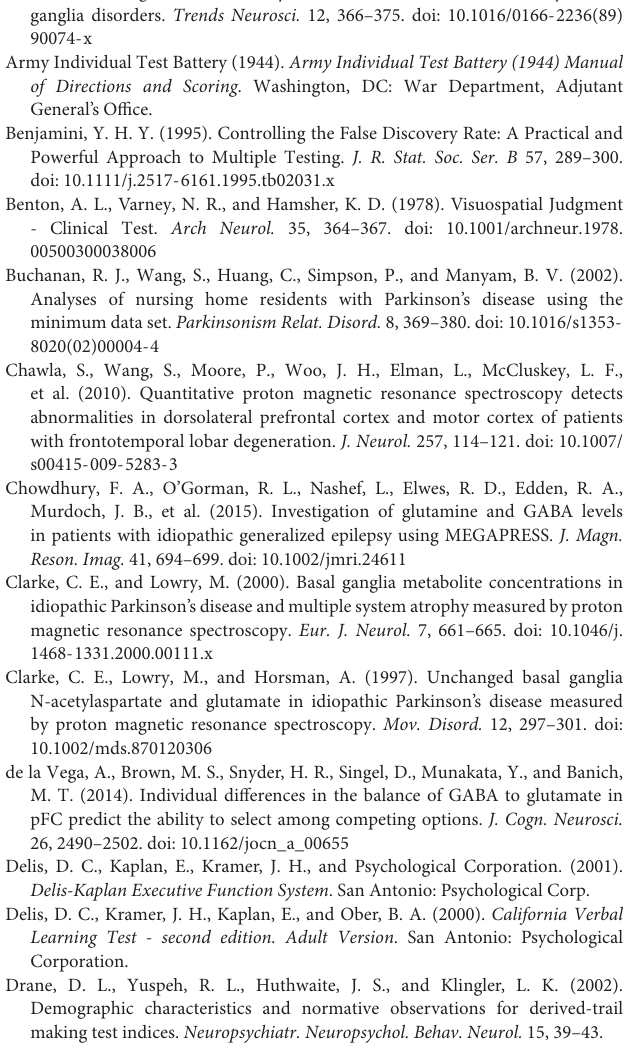
Supplementary Table 1 | Summary statistics for the creation of the composite scores. KMO, Kaiser-Meyer-Olkin Measure of Sampling adequacy; BTS, Bartlett’s Test of Sphericity. Supplementary Table 2 | Participant demographics. Data presented as mean (SD), range or fraction of participants. The high levodopa equivalence standard deviation indicates that the participants were spread out over a wide range of dosages. UPDRS, Unified Parkinson’s Disease Rating Scale. Bold text indicates statistically significant group differences. Supplementary Table 3 | CSF-corrected metabolite measures for CTL and PD-NC. Values are expressed as means ± SD. Using the Bonferroni correction for